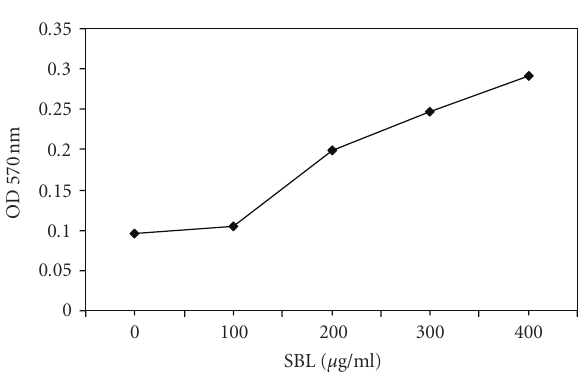
Figure 4: Optical density at 570 nm indicating biofilm formation in the microtiter plate assay by B. japonicum USDA 110 with or without 300 μ g ml − 1 SBL or BSA at the indicated incubation times.